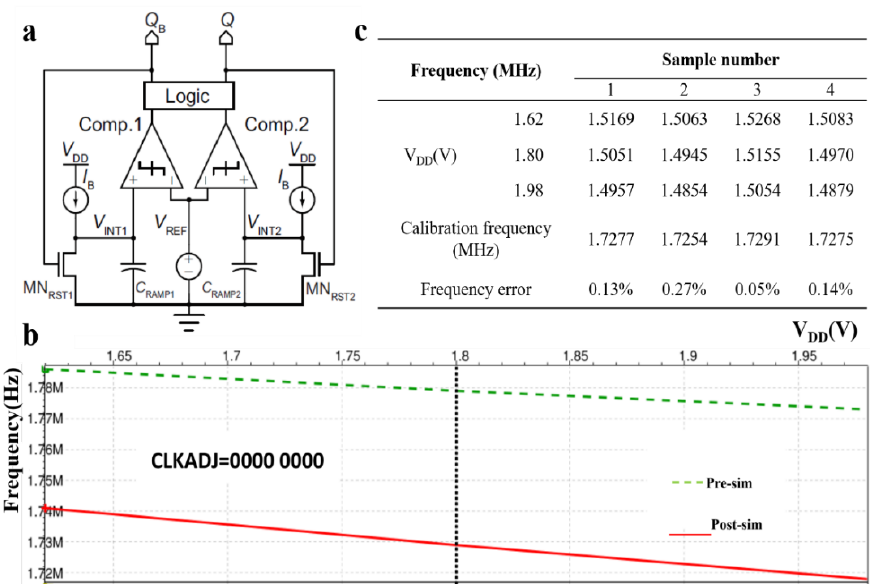
Figure 4. Realizing 1.73 MHz frequency of system (OSC) for TOF calculation. ( a ) The block diagram of the relaxation oscillator. ( b ) System frequency vs. power supply voltage by simulation, and ( c ) measurement results of the frequency vs. power supply.